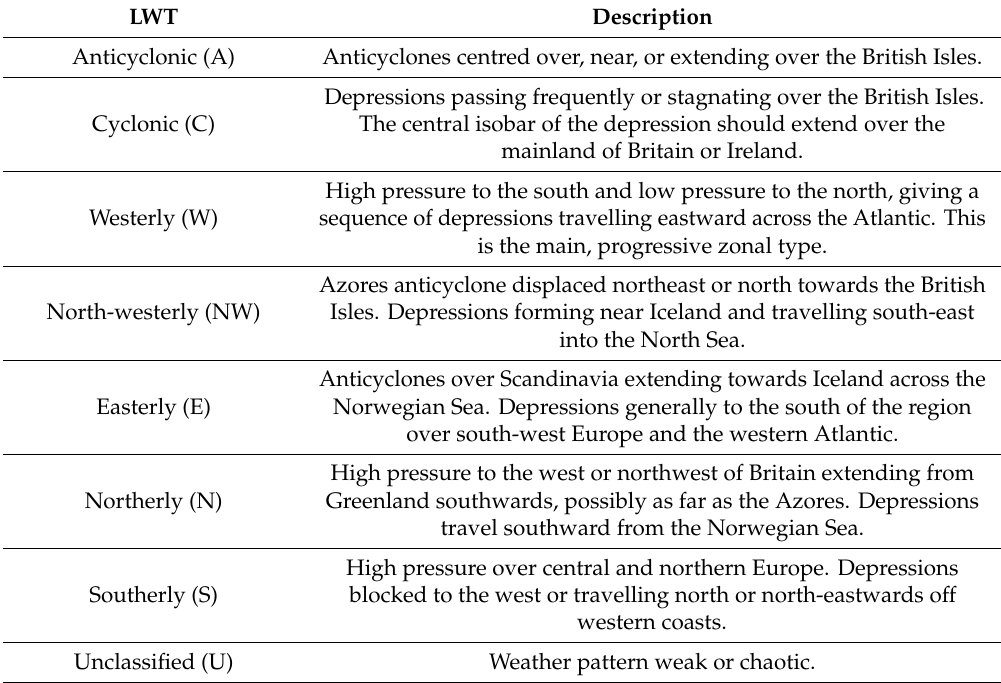
Table 1. Description of the seven main Lamb Weather Types (LWTs) and unclassified (U) type